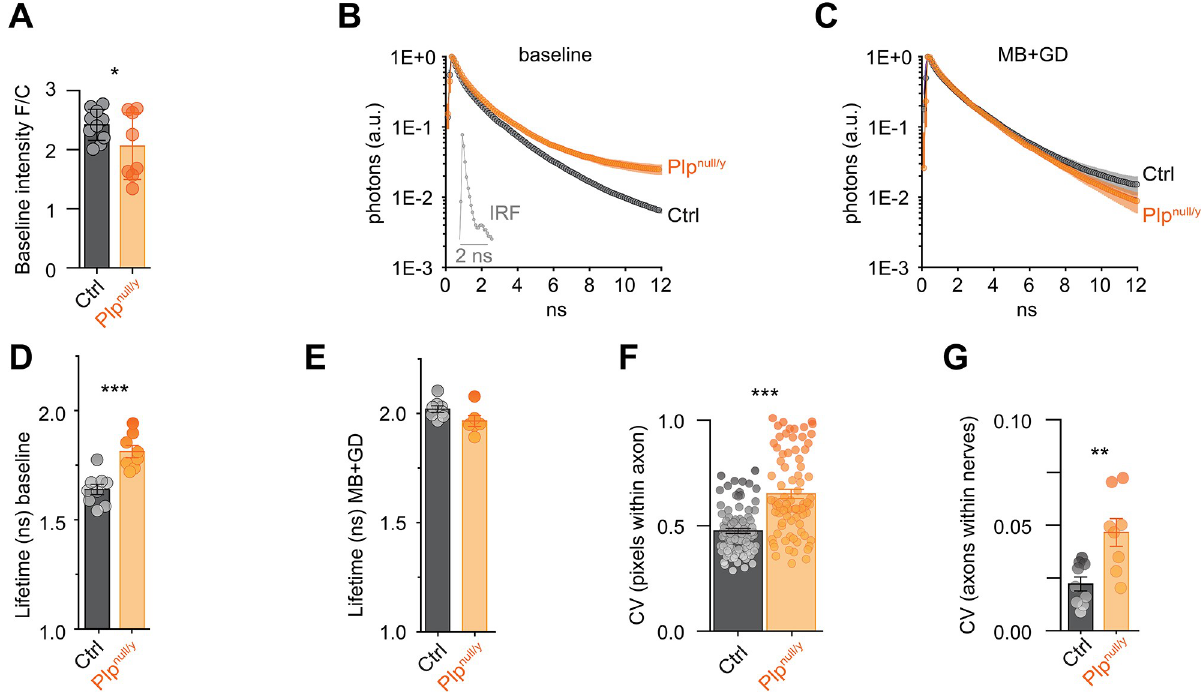
Fig 2. Axoplasmic ATP concentration is reduced in Plp null/y mice under basal conditions. (A) ATP sensor ratio at baseline conditions. n = 10 and n = 8 nerves from N = 10 and 8 mice (age 10 weeks) for ThyAT/ Plp wt/y (control [Ctrl]) and ThyAT/ Plp null/y ( Plp null/y ), respectively. (B) Fluorescence decay of the donor fluorophore of the ATP sensor in optic nerve axons of Ctrl and Plp null/y mice under baseline incubation conditions. A slower decay and, consequently, an increase of the fluorescence lifetime correspond to a decrease in ATP concentration. The inset shows the instrument response function (IRF). Shading represents SEM. (C) Average fluorescence decay of the same axons as in (B) but after depletion of ATP by mitochondrial blockage and glucose deprivation (MB+GD). (D) Quantification of the fluorescence lifetime � t (ns) of the ATP sensor in axons under baseline conditions, indicating a lower ATP concentration in Plp null/y nerves. (E) Quantification of the fluorescence lifetime � t (ns) of the ATP sensor in axons exposed to MB+GD, indicating that the longest fluorescent lifetime is obtained for each nerve under this energy-depriving condition. The average fluorescence decay of n = 6–9 nerves from N = 4–5 mice (10 weeks old) is shown in (B–E). (F) The variability of the ATP concentration within individual axons was analyzed by calculating the coefficient of variation (CV) of the fluorescence lifetime of all pixels within an axon; 88 and 79 axons from n = 9 and 8 nerves from N = 5 and 4 animals were analyzed for control and Plp null/y nerves, respectively. (G) CV of the ATP sensor fluorescence lifetime of axons within a nerve. 8 to 10 axons each from n = 9 and 8 nerves from N = 5 and 4 animals were included in the analysis for control and Plp null/y nerves, respectively. � p < 0.05, �� p < 0.01, ��� p < 0.001; Student t test (A, D, E, G), Welch’s test (F). Data underlying this figure can be found in S1